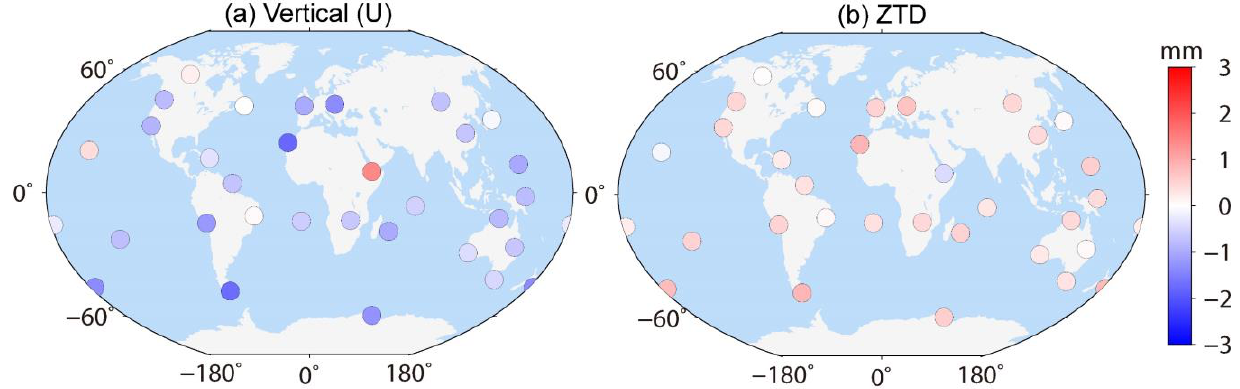
Figure 9. Bias distribution for U coordinate ( a ) and ZTD ( b ) between the two PPP schemes.